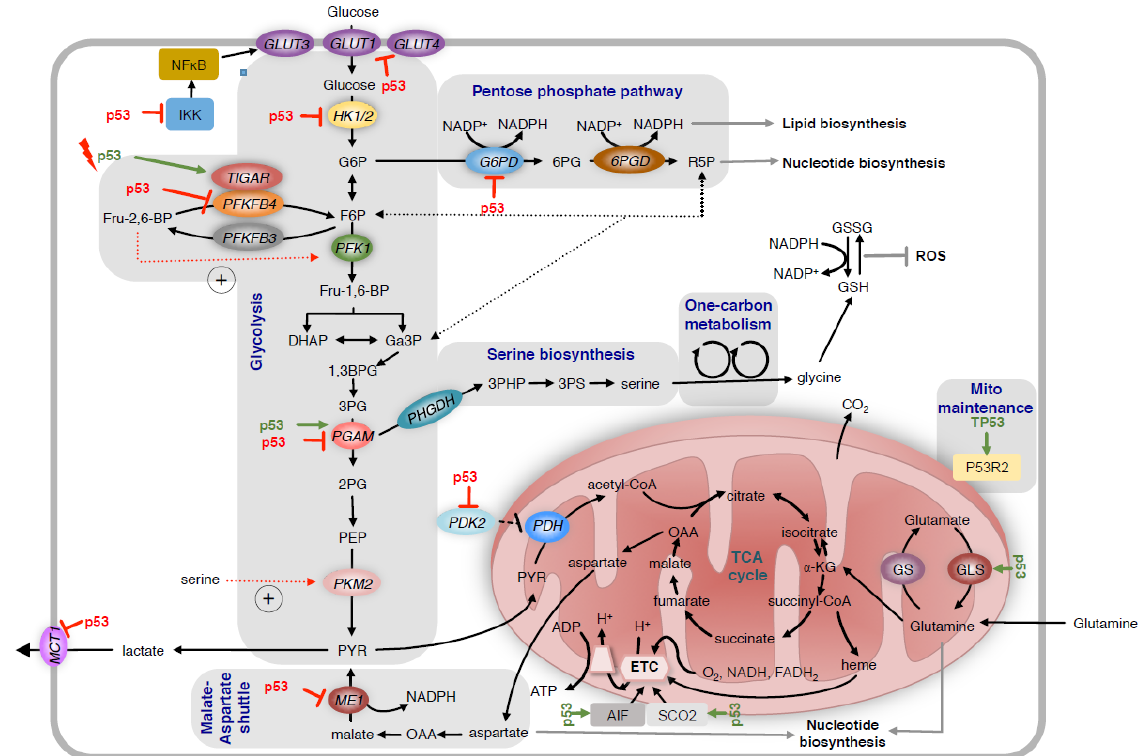
Figure 1. Regulation of glycolysis and mitochondrial metabolism by p53.